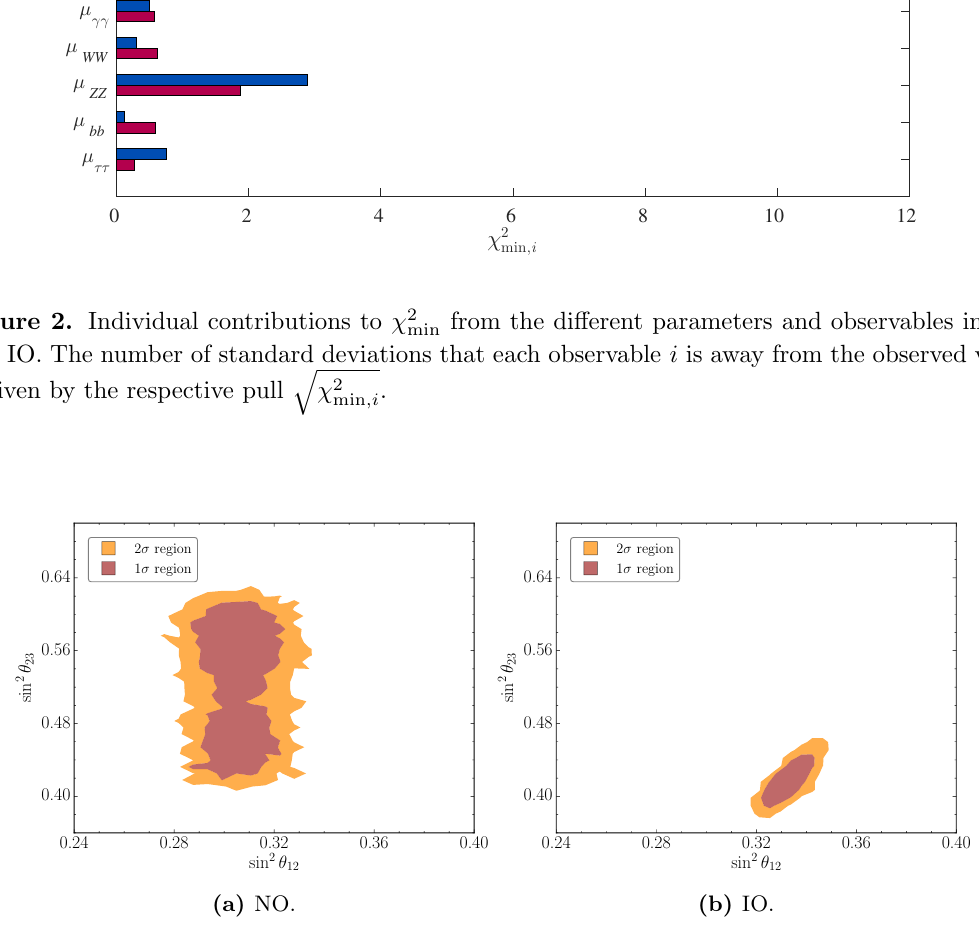
Figure 3. Allowed regions of the leptonic mixing parameters sin 2 (cid:18) 12 and sin 2 (cid:18) 23 for (a) NO and (b) IO. The 3 (cid:27) C.L. ranges from global (cid:12)ts to neutrino oscillation data [60, 61] are 0 : 271 < sin 2 (cid:18) 12 < 0 : 345 for both orderings and 0 : 385 (0 : 393) < sin 2 (cid:18) 23 < 0 : 635 (0 : 640) for NO (IO), see also table 4.